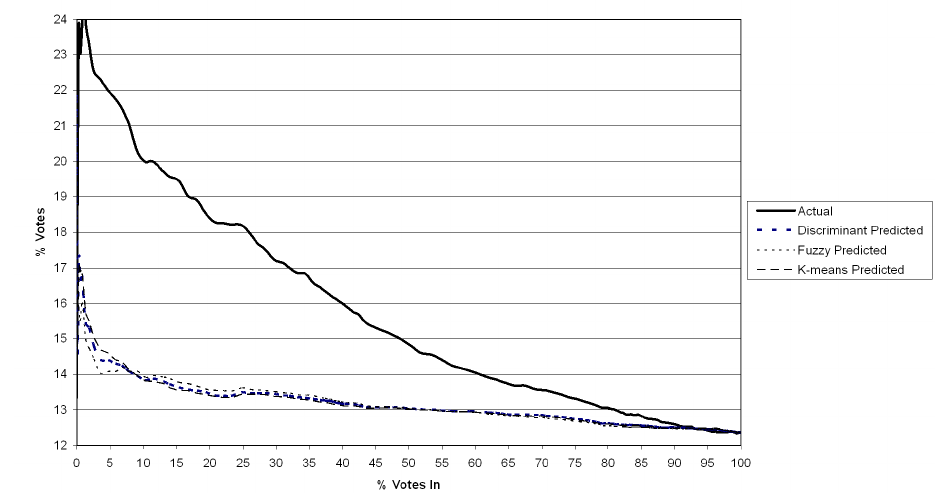
Figure 2: DA results for the national elections in 2004 and their predictions as a function of the number of votes